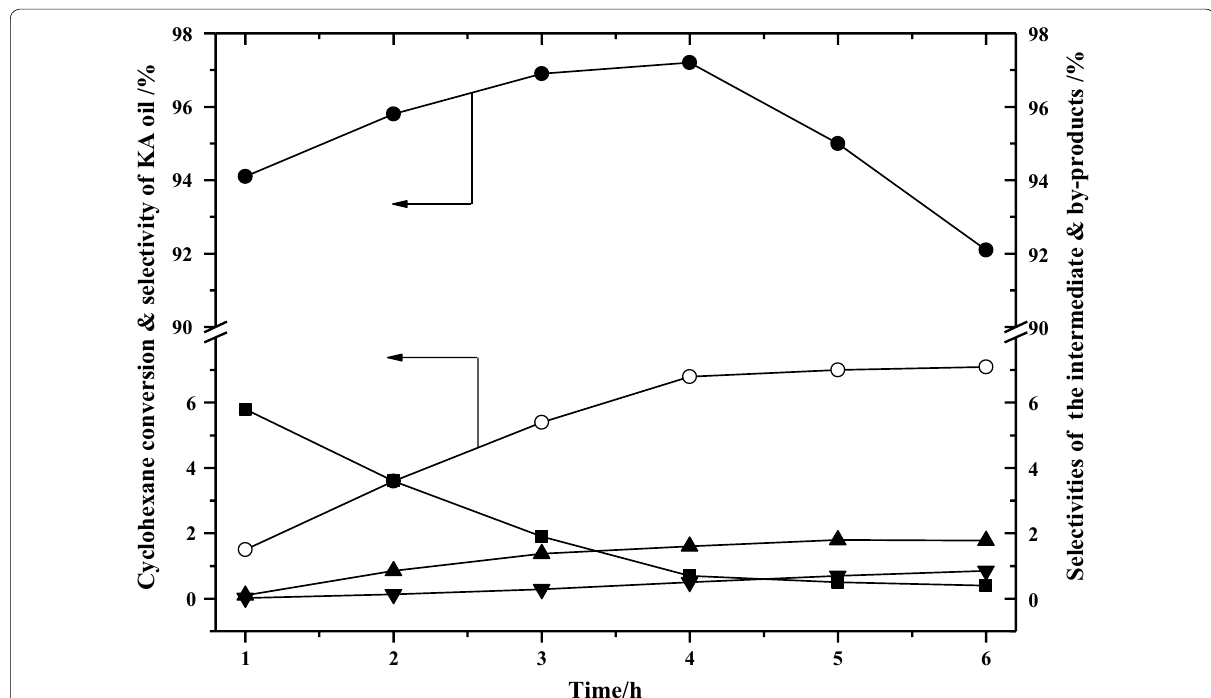
Fig. 6 Effect of reaction time on cyclohexane conversion, selectivities for the main product, intermediate product, and by-products. Reaction conditions: cyclohexane 100 mL, VAlPO 4 berlinite catalyst 5 mg, acetic acid solvent 40 mL, O 2 pressure 0.1 MPa, reaction time: 4 h. (White circle) cyclohexane conversion; (Black circle), (Black square), (Black up-pointing triangle) and (Black down-pointing triangle) selectivity for KA oil, CHHP, acids and esters, respectively. KA oil: cyclohexanol and cyclohexanone; CHHP: cyclohexyl hydroperoxide; acids: C 4 –C 6 diacids; esters: synthesized by the reaction of C 4 –C 6 diacids and